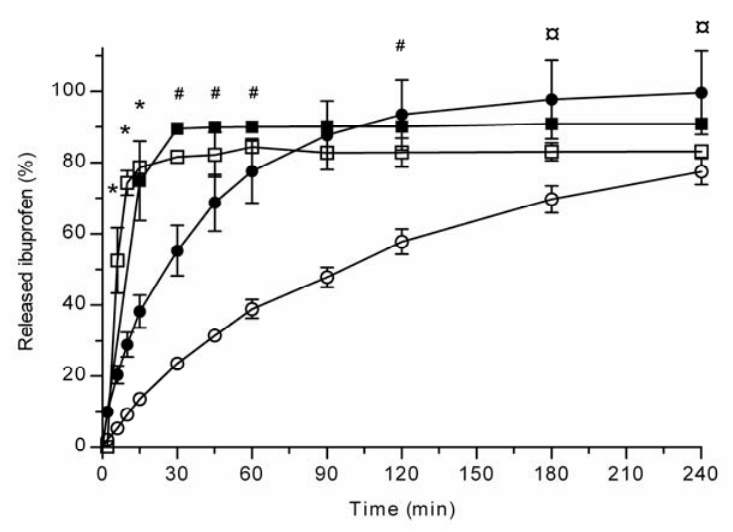
Figure 1. Ibuprofen release (%) from TCPSi microparticles at pH 7.4 PBS (+37 °C) with centrifuge ( ■ ), USP Apparatus 1 (basket) ( □ ) and well-plate methods (polyester ( ○ ) and polycarbonate ( ● ) membranes). Mean ± SD values are shown (n = 3), Statistical differences: *p < 0.05 USP Apparatus 1 vs . well-plate (polyester membrane), # p < 0.05 centrifuge vs . well-plate (polyester membrane), ¤ p < 0.05 well-plate (polycarbonate membrane) vs . well-plate (polyester